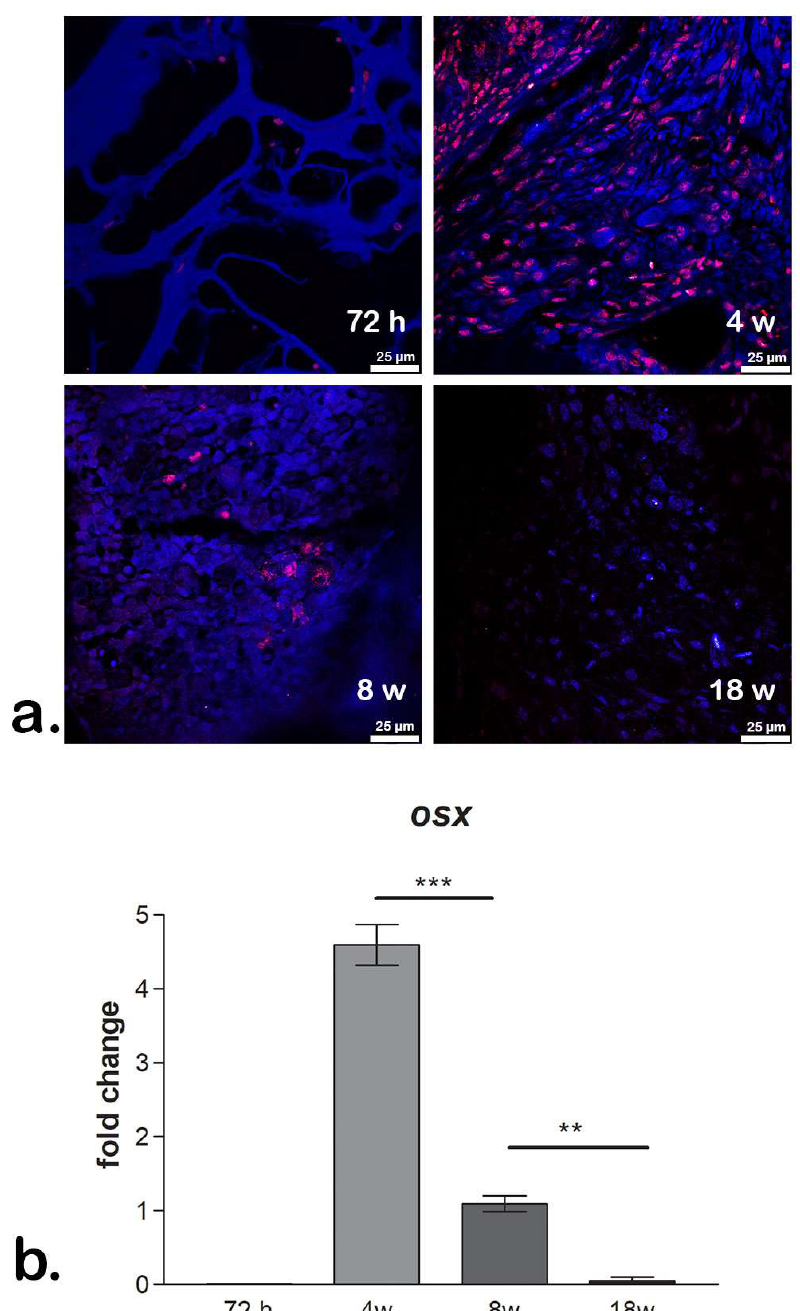
Figure 8. In vivo confirmation of osteogenesis activation. ( a ) Osx levels of protein expression in vivo after CHT / 3 wt.% GO material implantation in mouse calvaria bone defect; ( b ) osx gene expression profile during 18 weeks post-implantation. ** p < 0.01; *** p < 0.001. Fold change in qPCR data analysis was determined by 2 −ΔΔCt method.